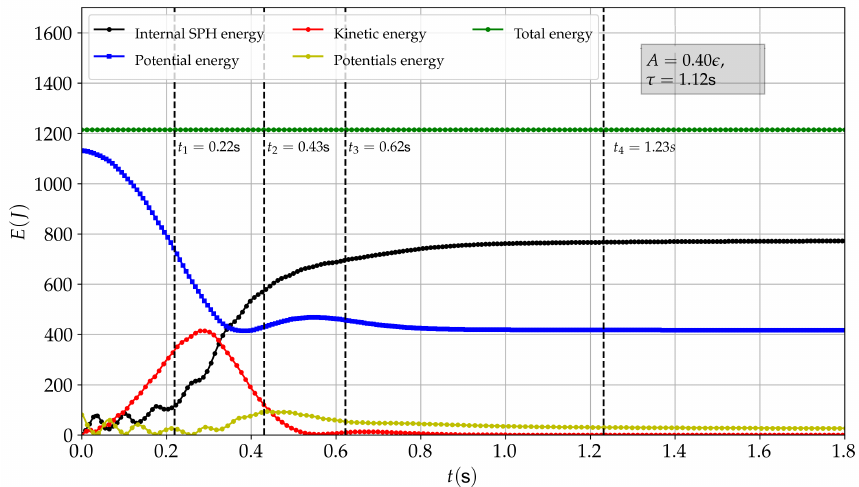
Figure 36. Energy budget vs. time for a viscoelastic substance. (cid:101) CS = 1 × 10 − 3 , A = 0.4 (cid:101) CS .